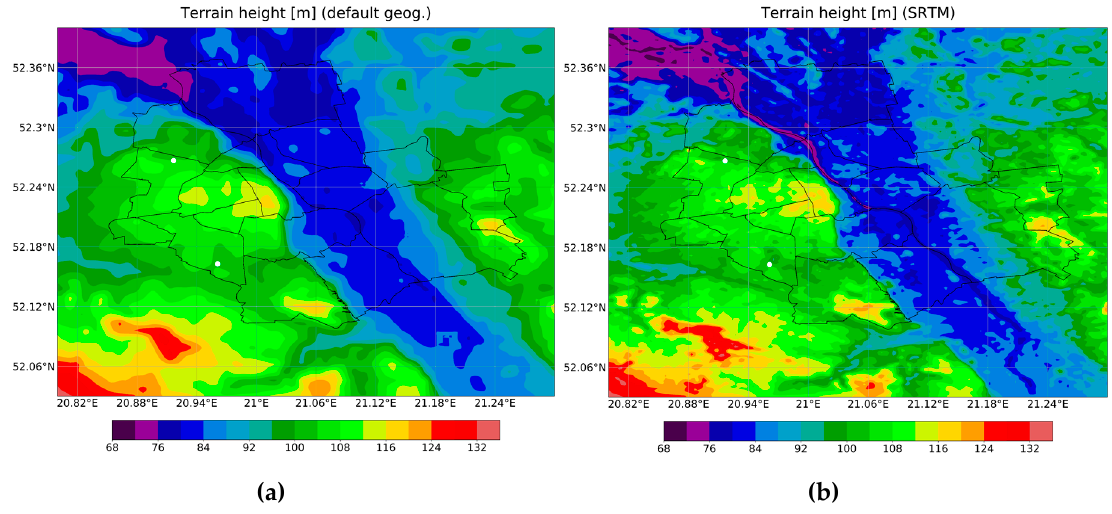
Figure 4. Terrain height used in the WRF simulations for domain 3 (200 × 200 m) with ( a ) GMTED2010 topography; ( b ) SRTM topography.